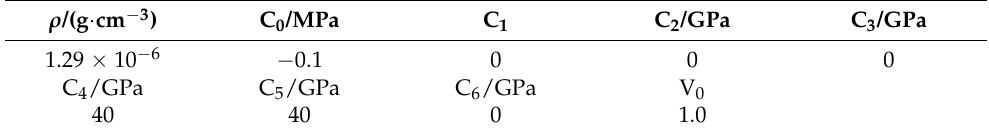
Table 8. Air material model